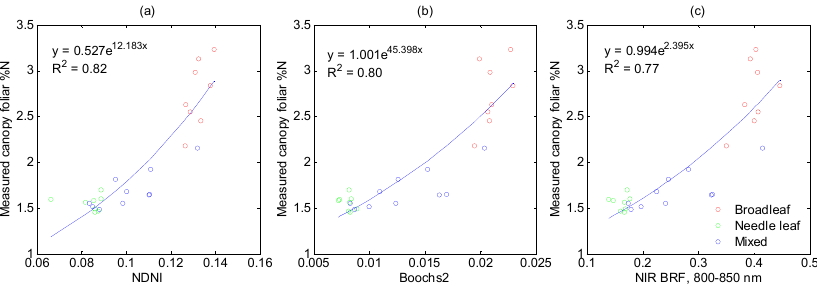
Figure 2. Relationships between the best performing vegetation indices: ( a ) NDNI 1510 ; ( b ) Boochs2; and ( c ) NIR BRF, 800–850 nm and canopy foliar %N.